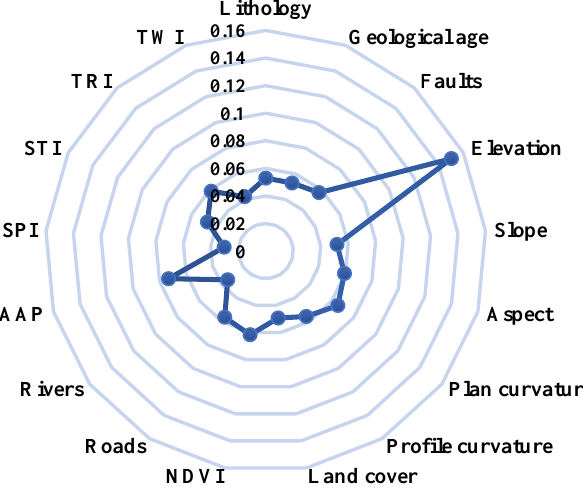
Figure 9. The radar plot of susceptibility factors importance of the landslides.